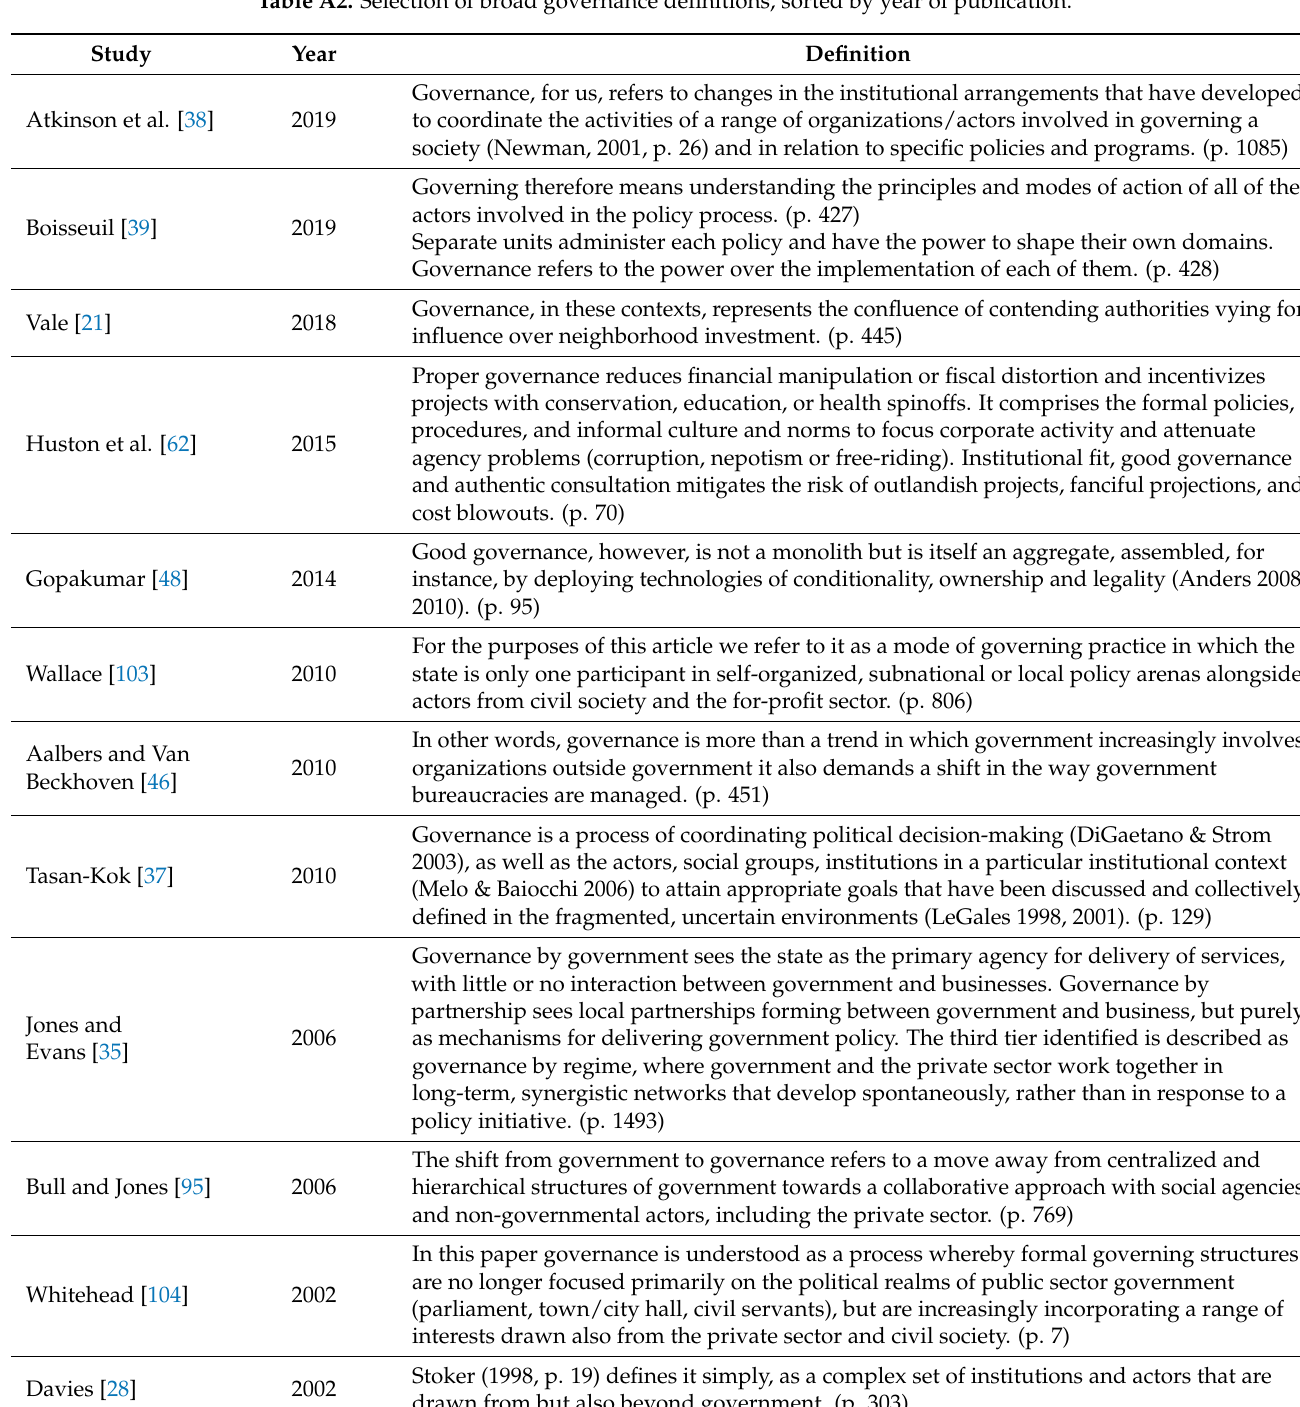
Table A2. Selection of broad governance definitions, sorted by year of